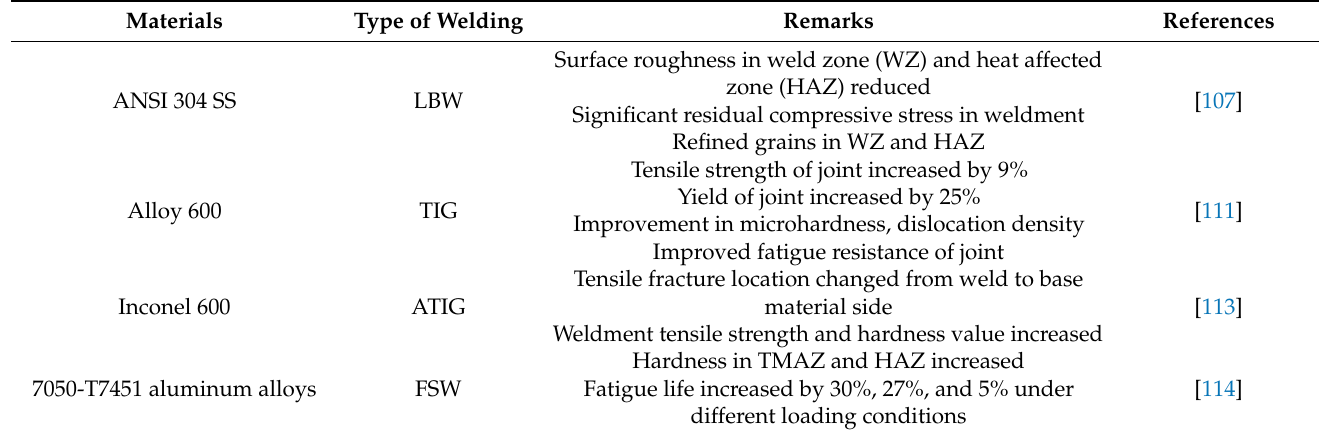
Table 4. Effect of LSP on various weld joints.